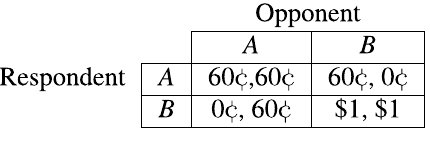
Figure 5. Stag and hare